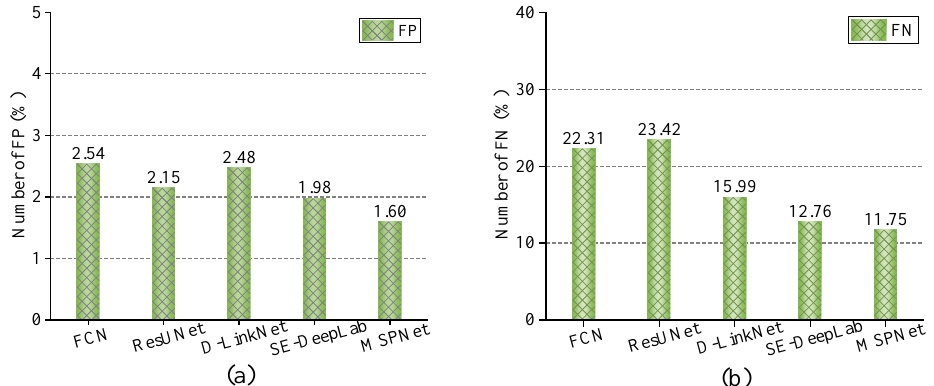
Figure 9. ( a , b ) respectively plot the comparison methods on misclassification percentages of false positive (FP) and false negative (FN) in the results of three samples in Figure 8.